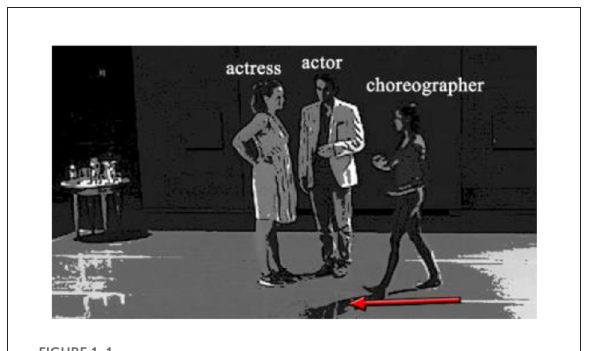
FIGURE1.1 CHO walks toward ACF and ACM.